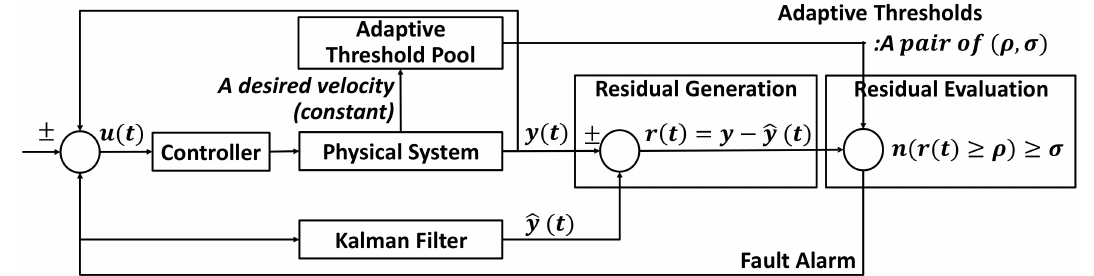
Figure 2. Overall architecture of the proposed fault detection